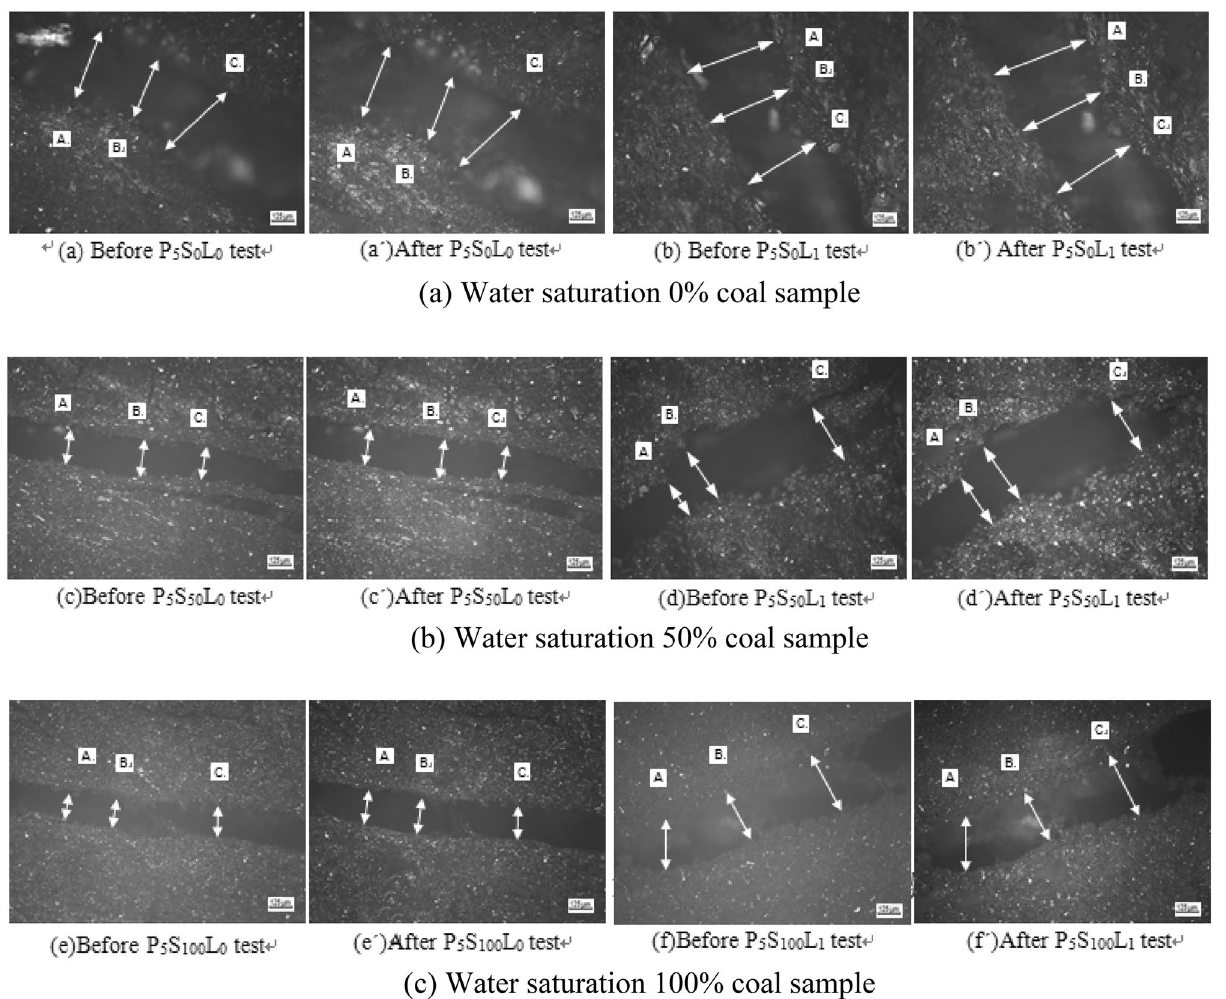
Figure 2. Comparison of coal sample joints before and after the